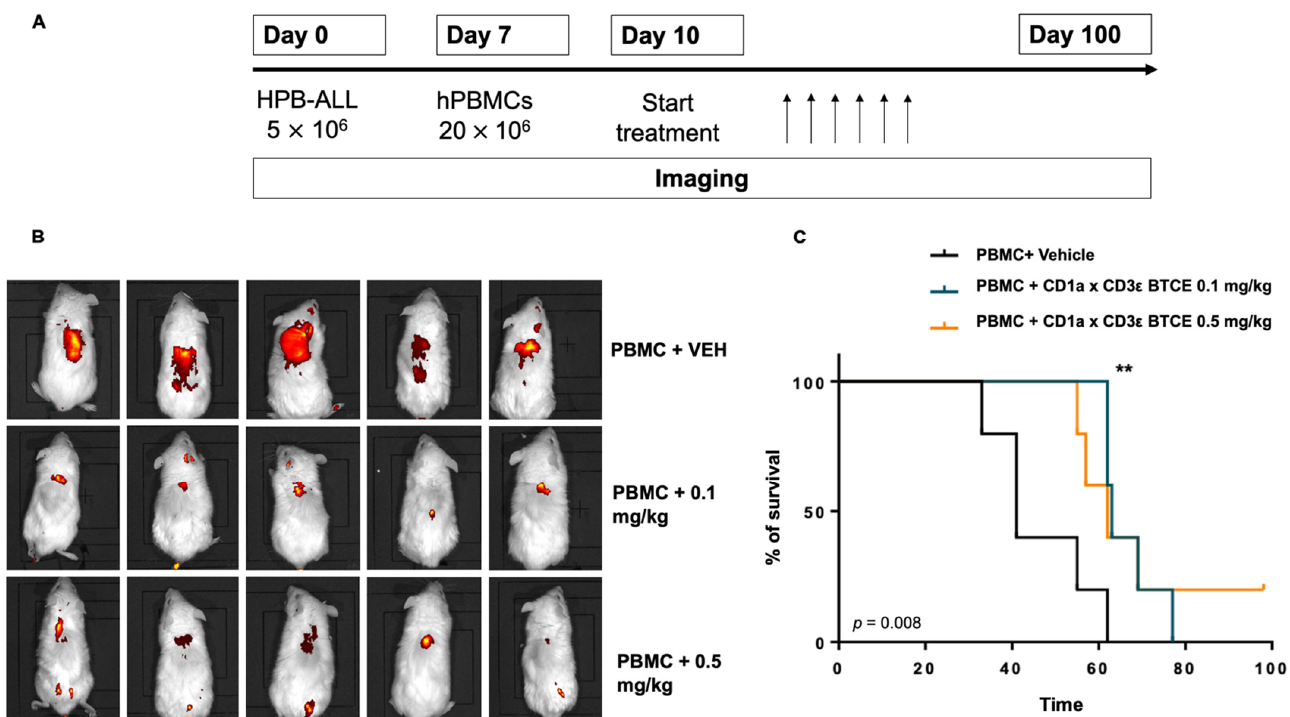
Figure 5. CD1a x CD3 ε BTCE in vivo activity. ( A ) Schematic representation of in vivo experiment. ( B ) Fluorescence in vivo imaging of mice engrafted with human healthy donor derived PBMCs and subsequently treated with the BTCE at 0.1 or 0.5 mg/kg, as compared to vehicle at day 28. ( C ) Survival curves (Kaplan–Meier) of mice engrafted with human healthy donor derived PBMCs and treated with CD1a x CD3 ε BTCE or vehicle (log-rank test, p < 0.05). ** p < 0.01.